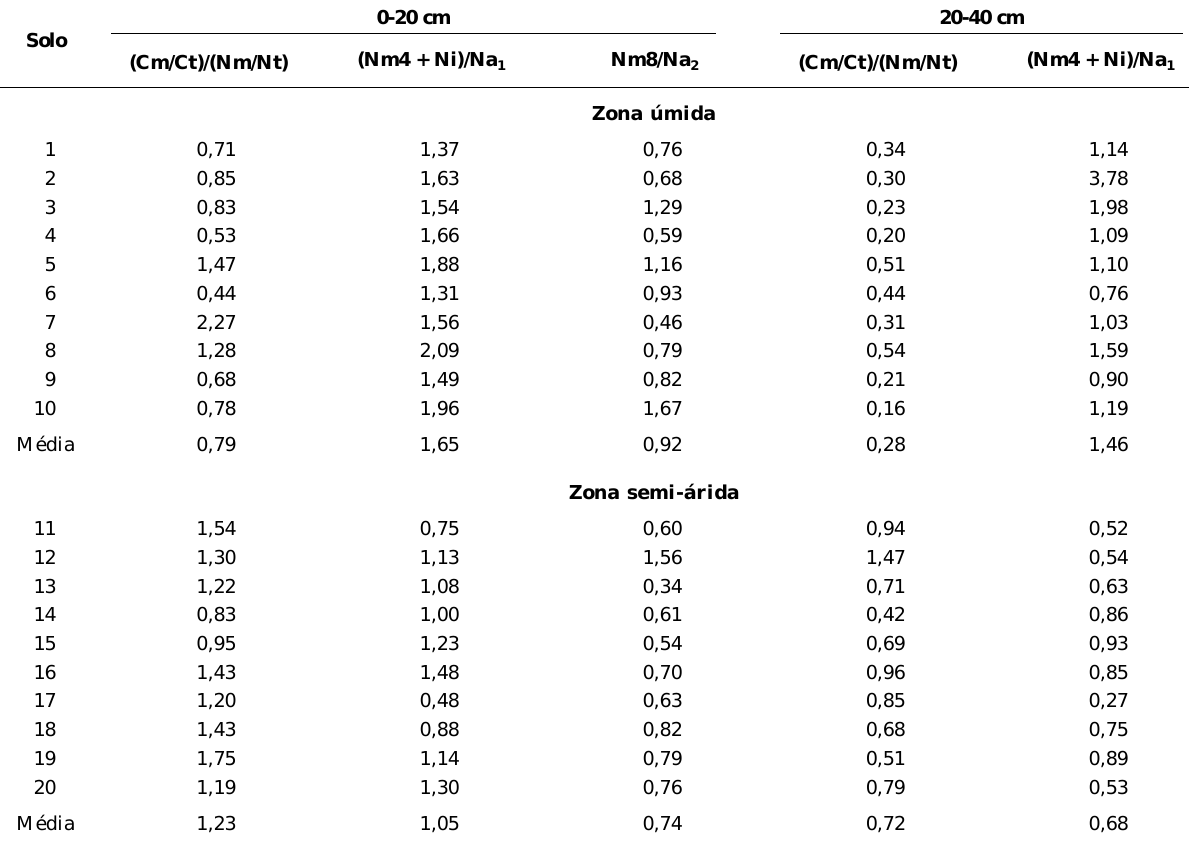
Quadro 2. Relações entre as proporções de C e N totais (Ct e Nt) mineralizados (Cm e Nm), em 20 e em 4 semanas de incubação, em amostras das camadas de 0-20 e 20-40 cm de profundidade, respectivamente, de solos da zona úmida e da semi-árida, entre o N mineralizado (Nm) acrescido do N mineral inicial (Ni) e o N absorvido por plantas cultivadas durante 30 dias (Na1) e entre o N mineralizado de 4 a 8 semanas de incubação (Nm8) e o N absorvido pelas plantas em um segundo cultivo por 30 dias